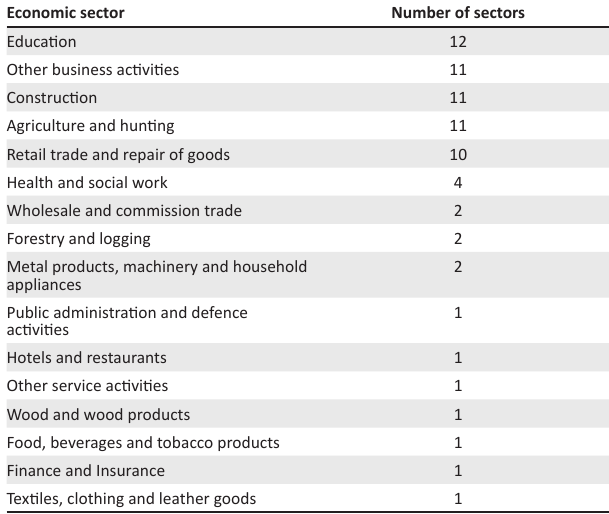
TABLE 3: Description of the data: Panel C (most common city-industries in the 12